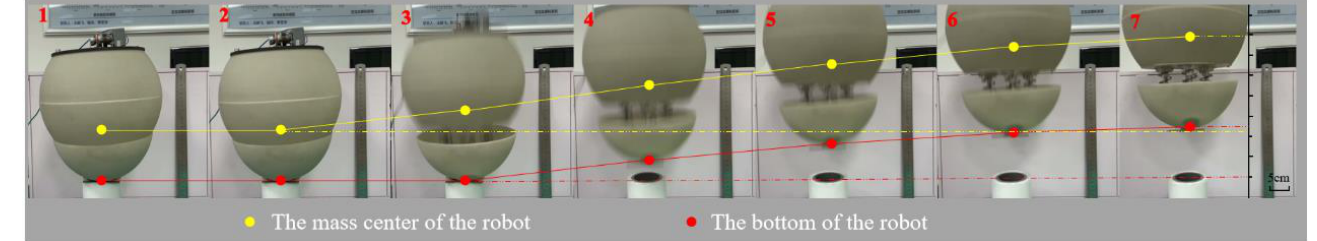
Figure 19. Jumping motion of robot.